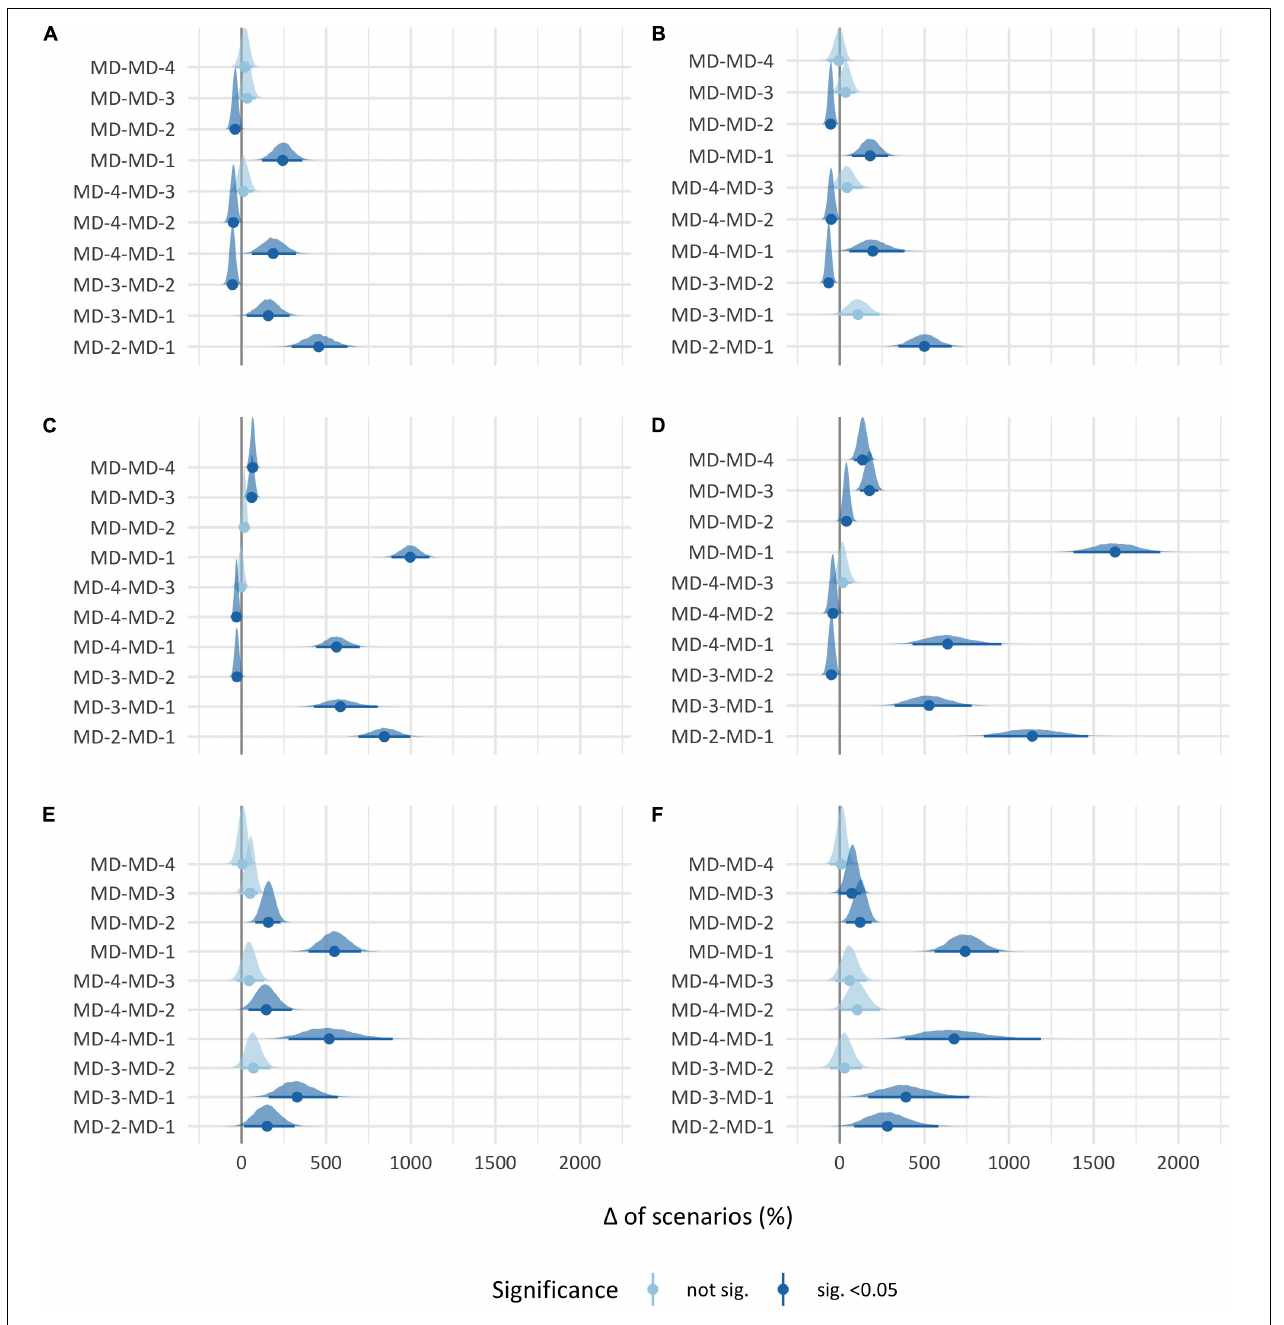
FIGURE 1 | 95% Confidence interval percentage change of high plus very high-demanding scenarios between match days. Each point represents the mean percentage change, and each black line through the point represents the 95% confidence interval of the percentage change between the two match